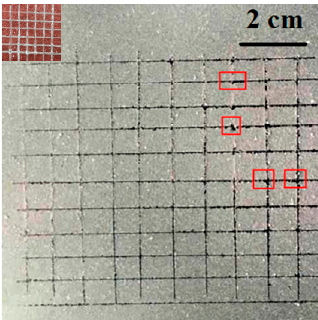
Figure 6. Adhesion testing of fluorocarbon superhydrophobic coating.